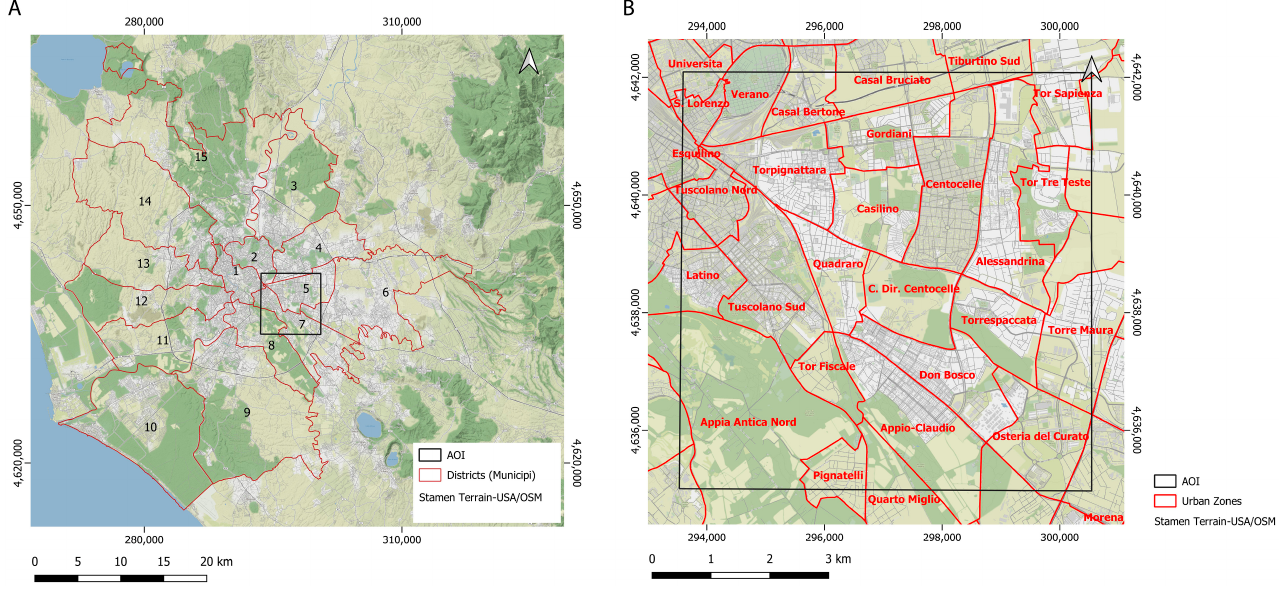
Figure 1 . ( A ) Area of Interest (AOI) and the fifteen districts (municipi and their conventional identification numbers) of the city of Rome (vector retrieved from [49] under a IODL 2.0